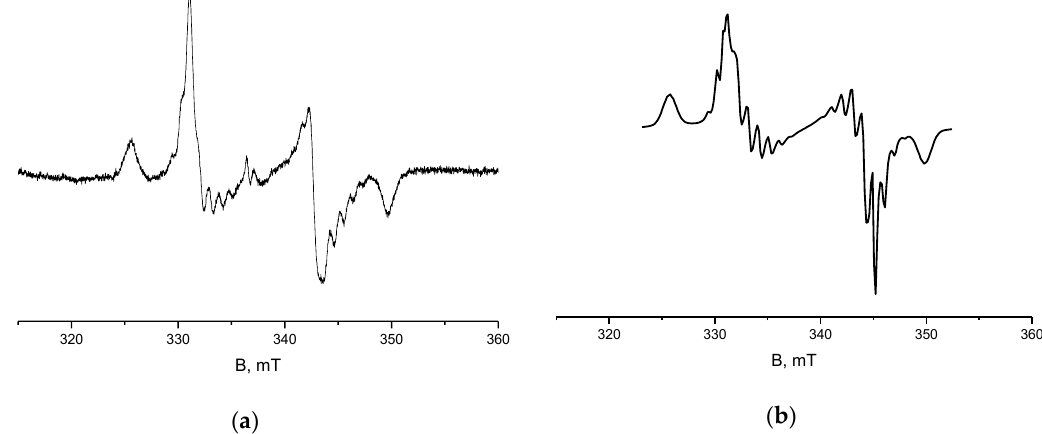
Figure 3. The electron spin resonance (ESR) spectrum of diradical 1 in a diluted glassy solution: experiment ( a ) and modeling ( b ).